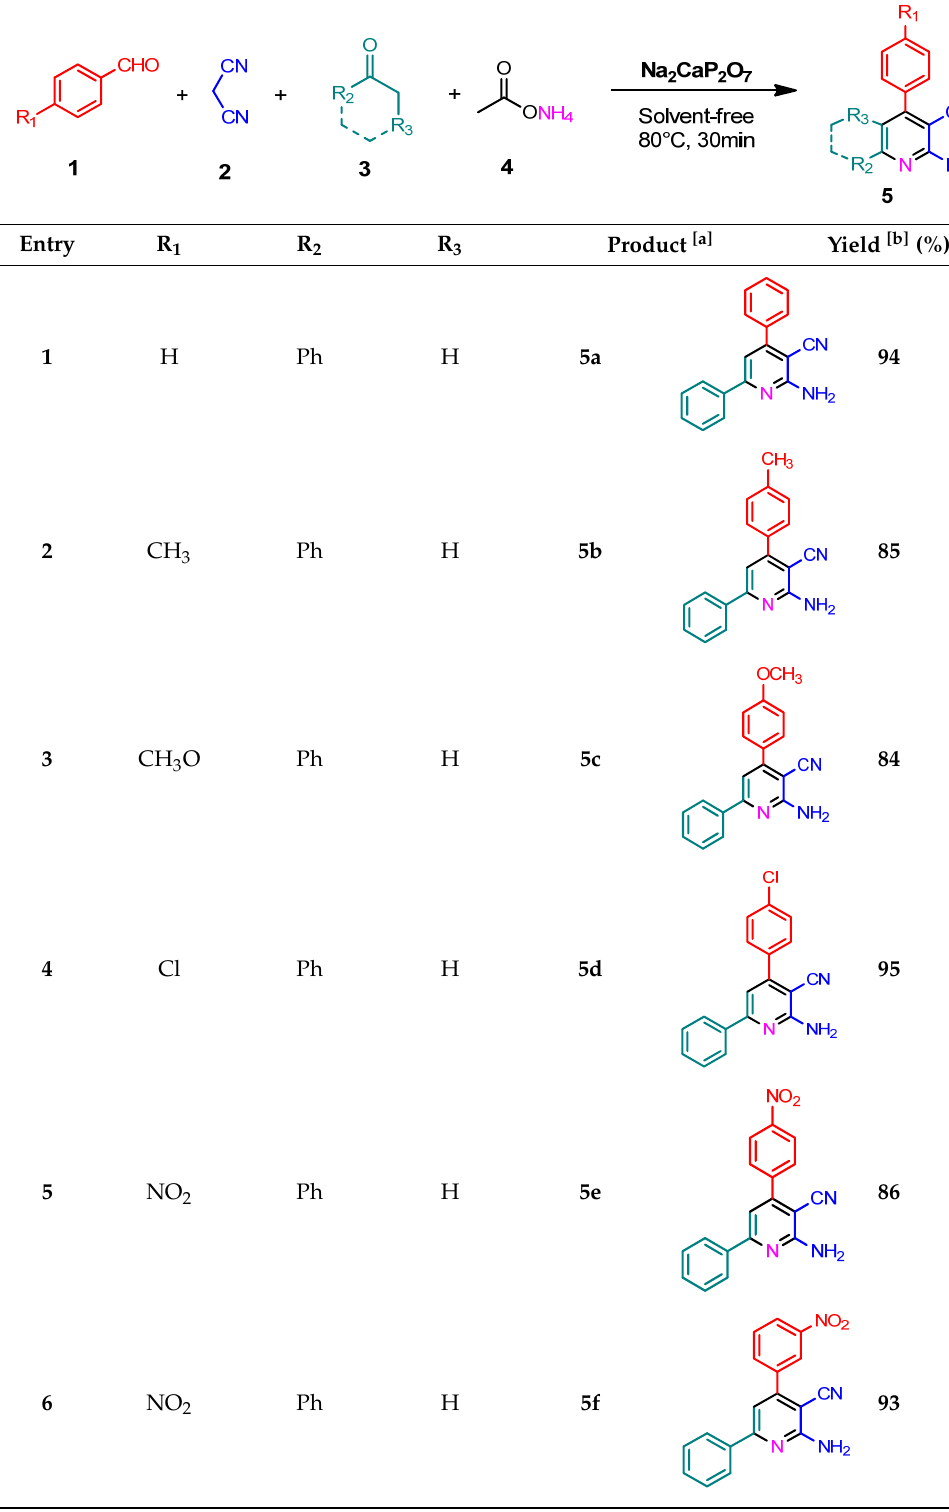
Table 2. Synthesis of 2-amino-3-cyanopyridine derivatives 5 .